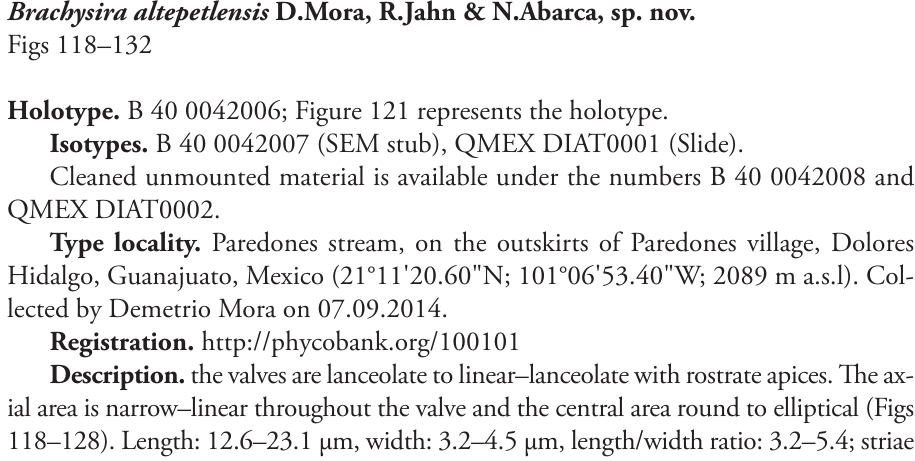
Holotype. B 40 0042006; Figure 121 represents the